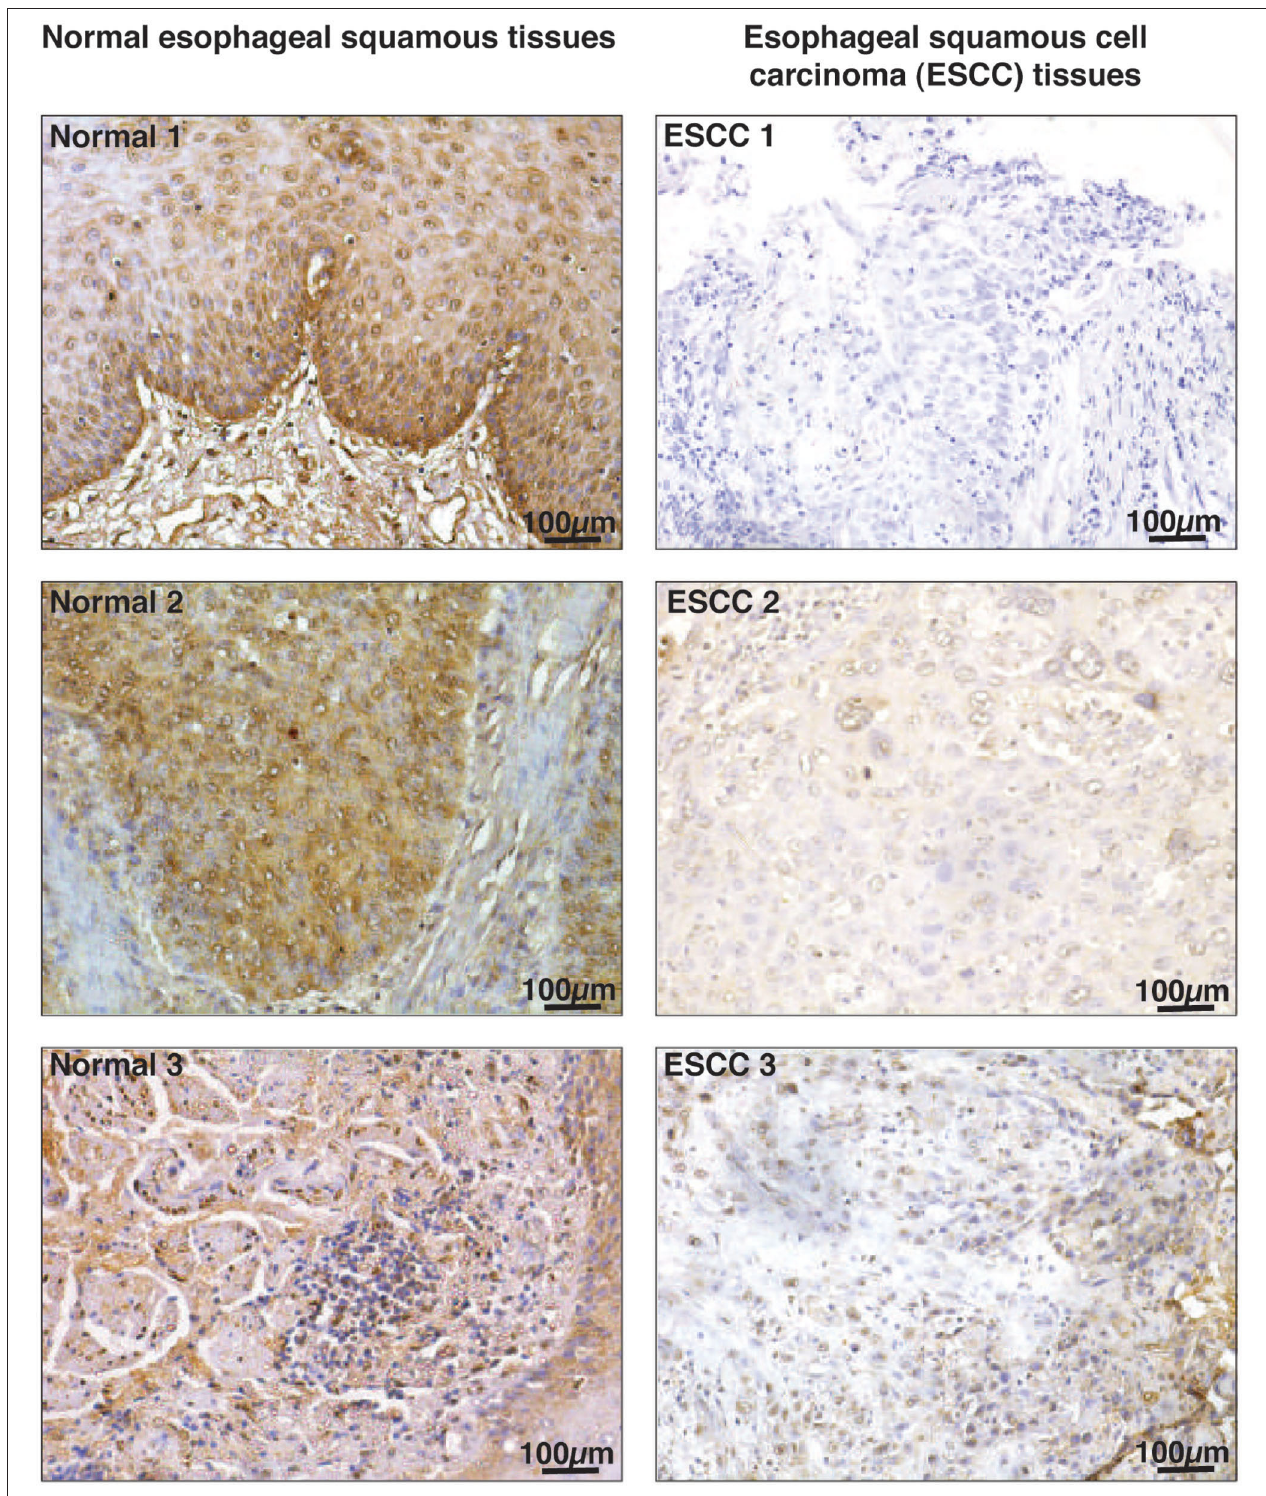
FIGURE 6 | Immunohistochemical validation of HMGN2 in ESCC tissue sections and adjacent normal. Tissue sections from ESCC and adjacent normal were stained with anti-HMGN2 antibody. Scale bar represents 100 µ m.